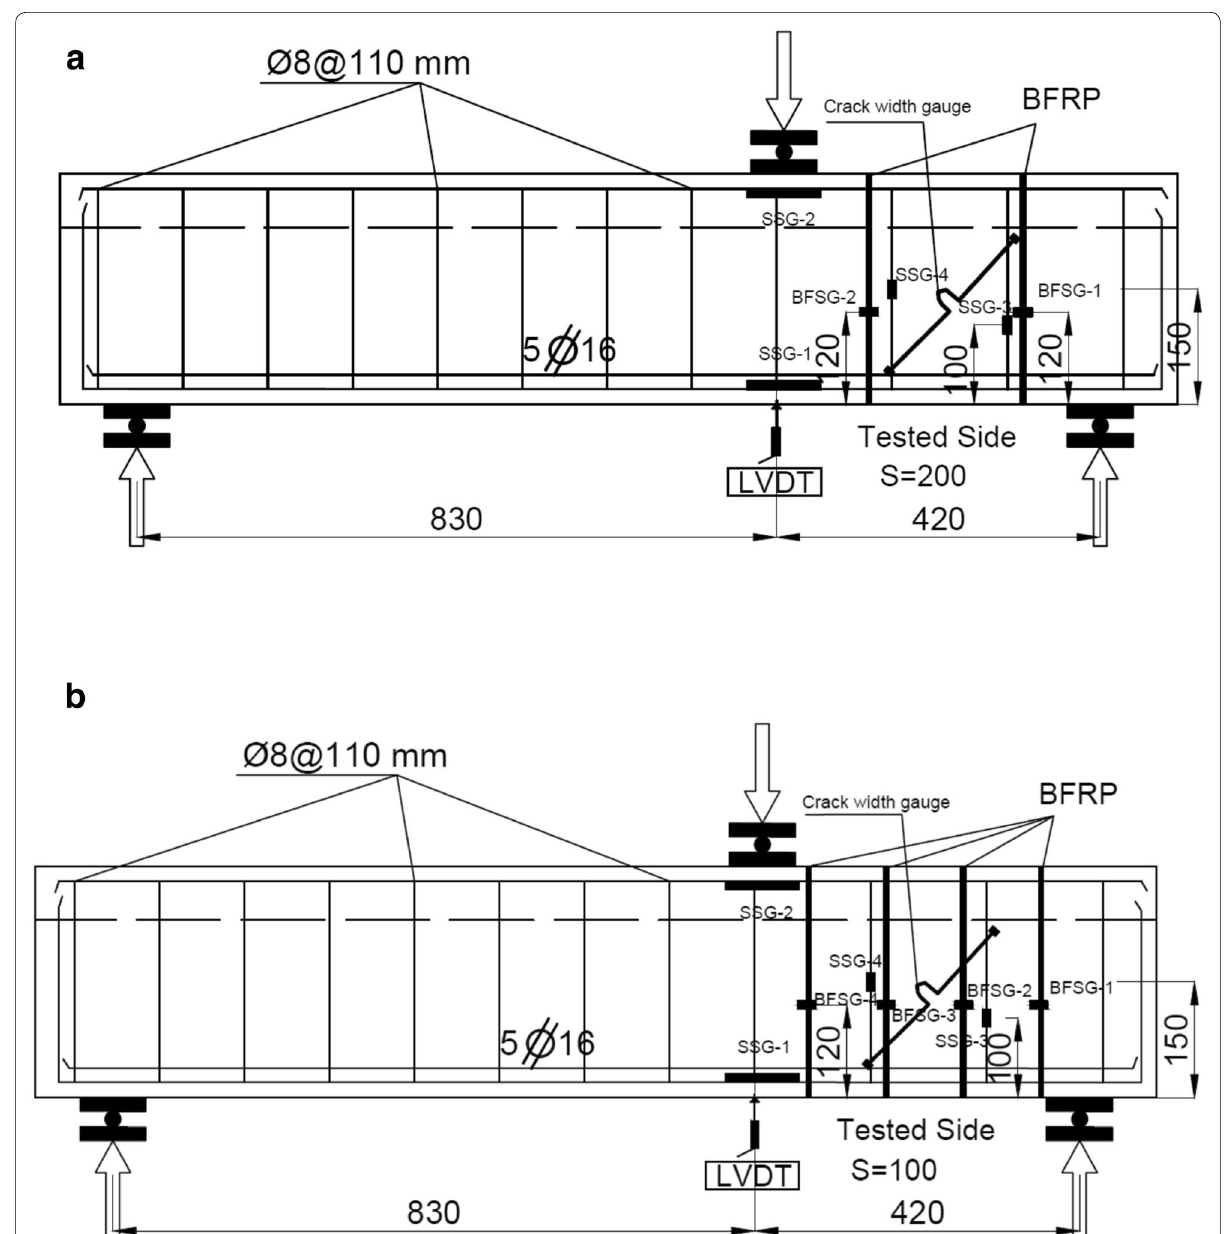
Fig. 8 Beam details and instrumentation: a s